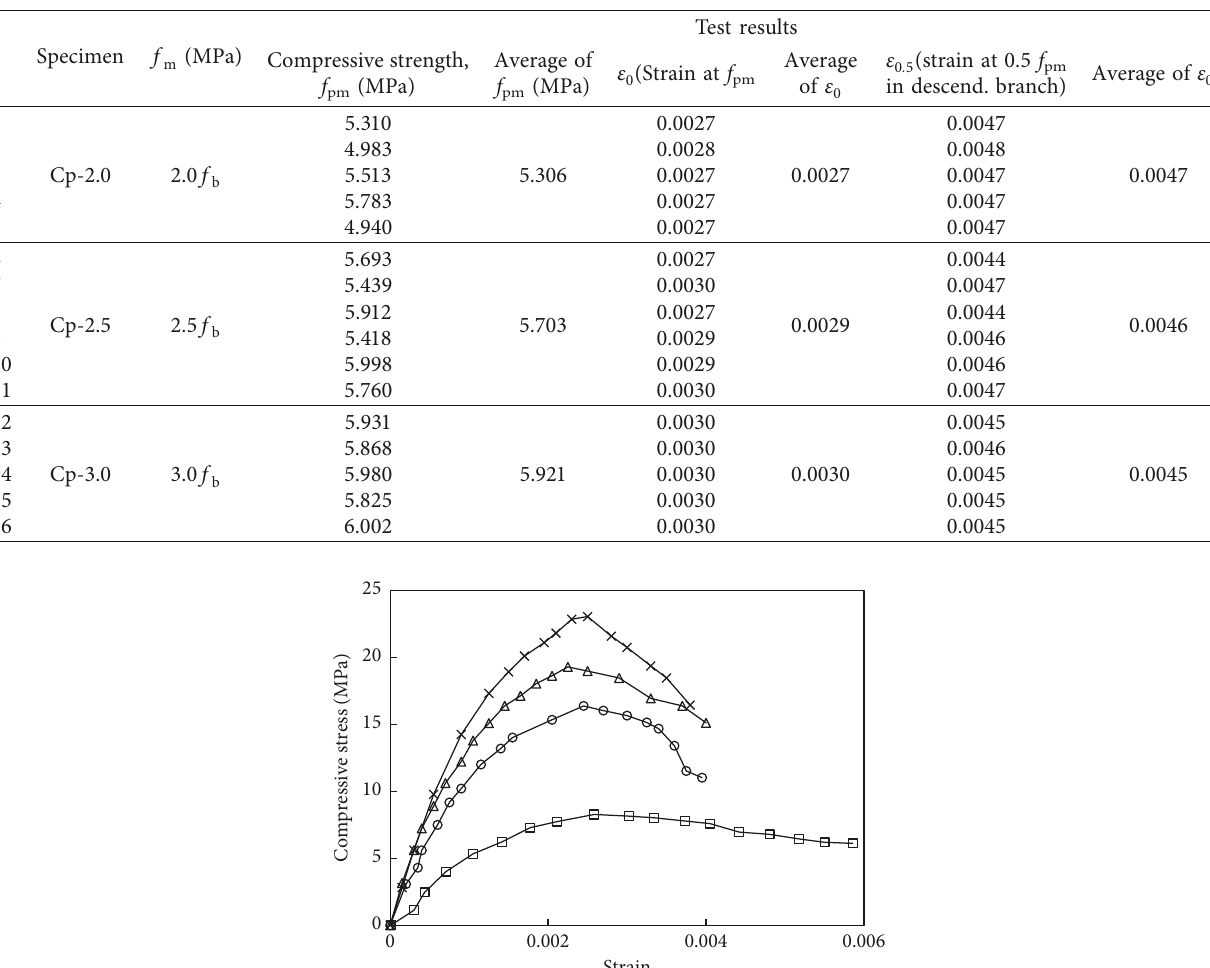
Table 3: Test parameters and test results.